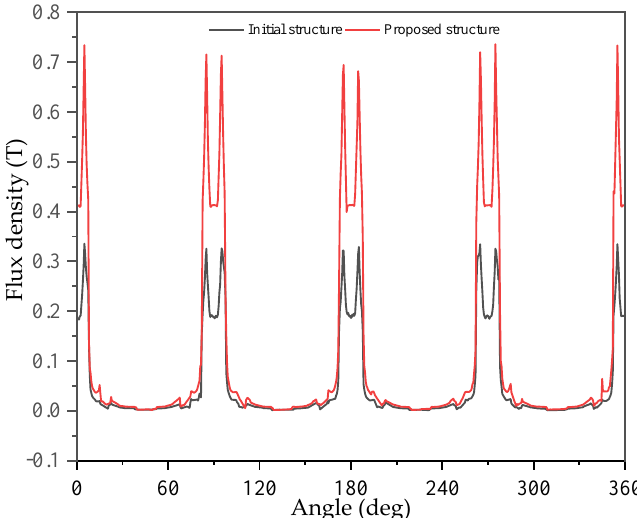
Figure 4. Permanent magnet bias flux density before and after adding a magnetic sleeve.